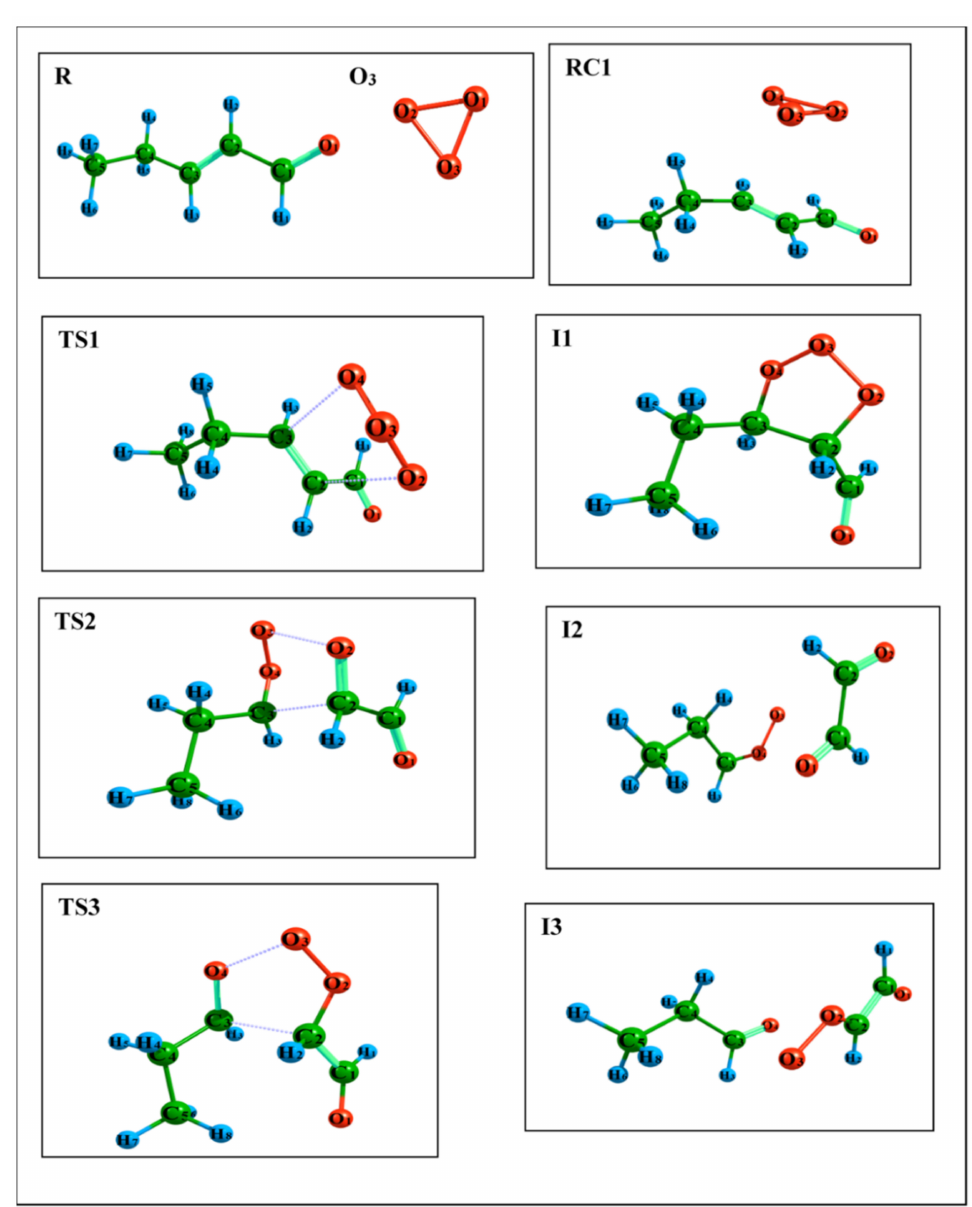
Figure 5. The optimized stationary points of the reaction of trans-2-pentenal with O 3 . At the entrance channel, a reactant complex (RC1) without any barrier is formed. A transition state (TS1) is observed with a negative energy barrier in all four levels of theory (M06-2X, BHandHLYP, MP2 and CCSD(T)). The corresponding intermediate I1 (ozonide) with high exothermicity of − 88.95 kcal/mol with respect to RC1 is located at M06-2X theory as shown in Table